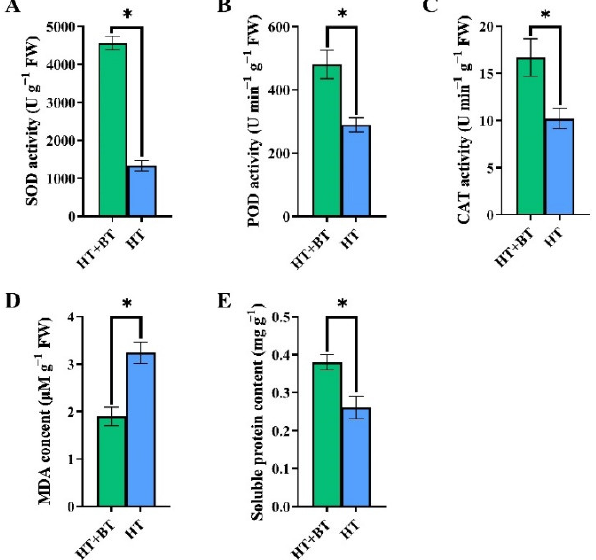
Figure 2. Effects of soaking seeds with 10 mM betaine on antioxidant enzyme system and soluble protein content of rice seeds under heat stress. Each parameter * indicates significant statistical difference, * ( p < 0.05): ( A ) SOD activity; ( B ) POD activity; ( C ) CAT activity; ( D ) MDA content; ( E ) soluble protein